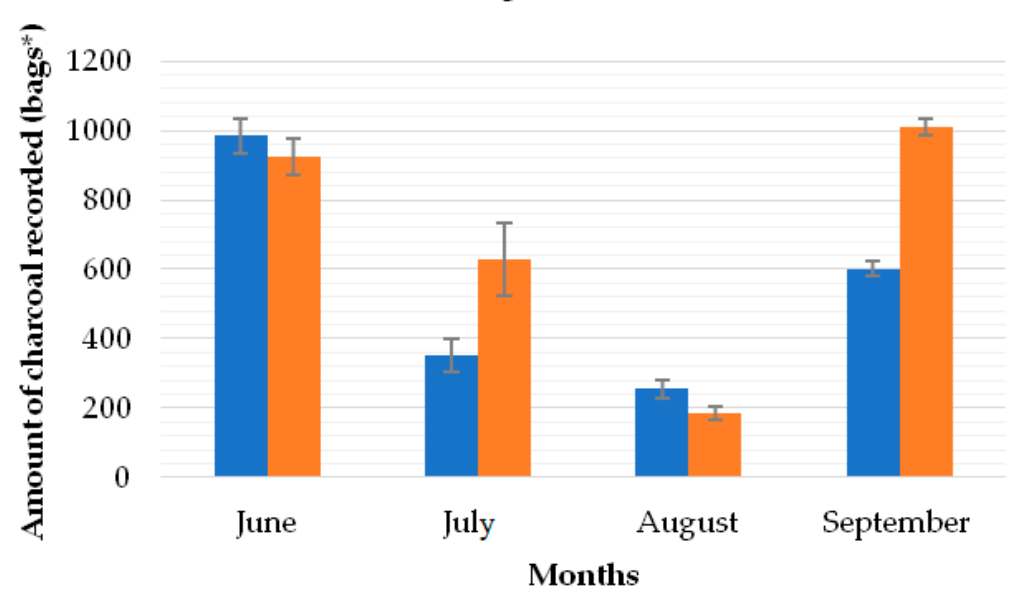
Figure 3. Seasonal trend of charcoal supplied in charcoal market of Bié province (2013–2014). * 1 bag of charcoal weighed about 38 kg.